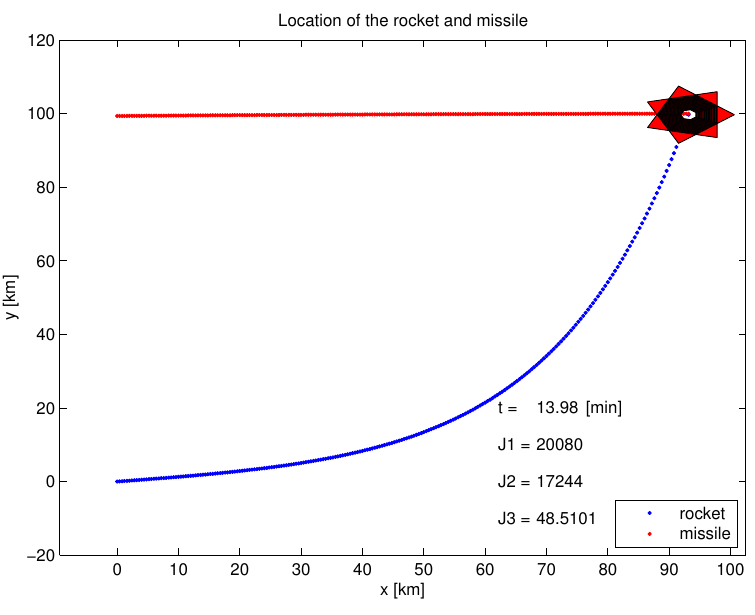
Figure 11. Visualisation of the interception process for default parameters.